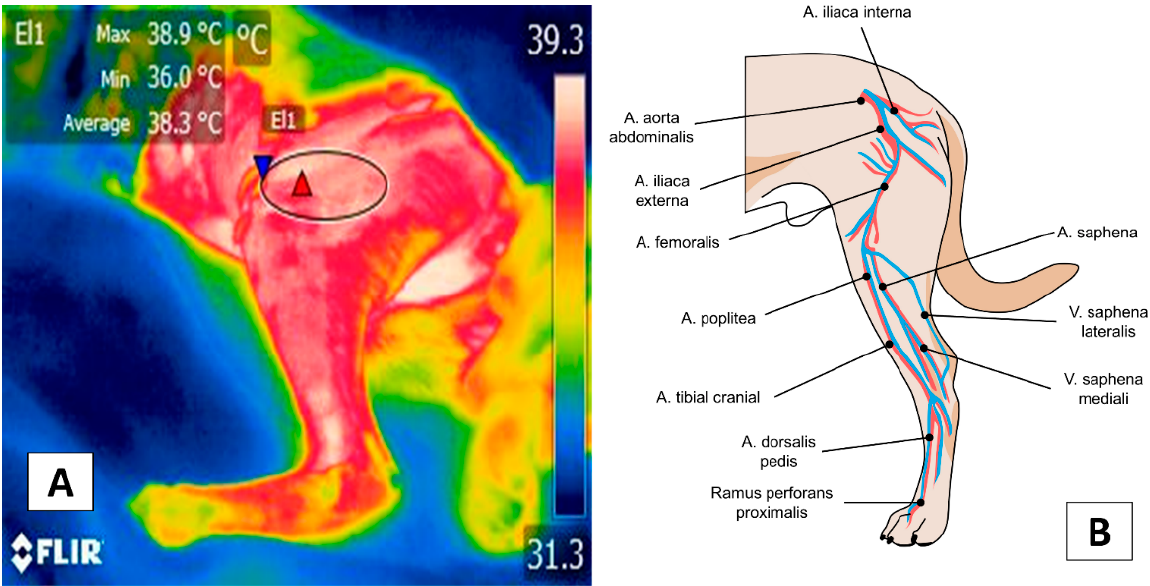
Figure 5. Appendicular window: ( A ) Femoral thermal window (El1). The tracing of this window is through an ellipse of approx- imately 3 cm located in the cranial region where the quadriceps femoris muscles ( quadriceps femoris ) lie and considering the cranial region of the tensor fasciae latae ( tensor fasciae latae ). ( B ) Circulation at the femoral level. The femoral thermal window obtains its circulation from the femoral artery ( arteria femoralis ) and its branch with the lateral circumflex artery ( circumflexa femoris lateralis ) that nourishes the previously described muscles that confer the importance of this window for the evaluation of the temperature. Thermal images obtained using a FLIR thermal camera.